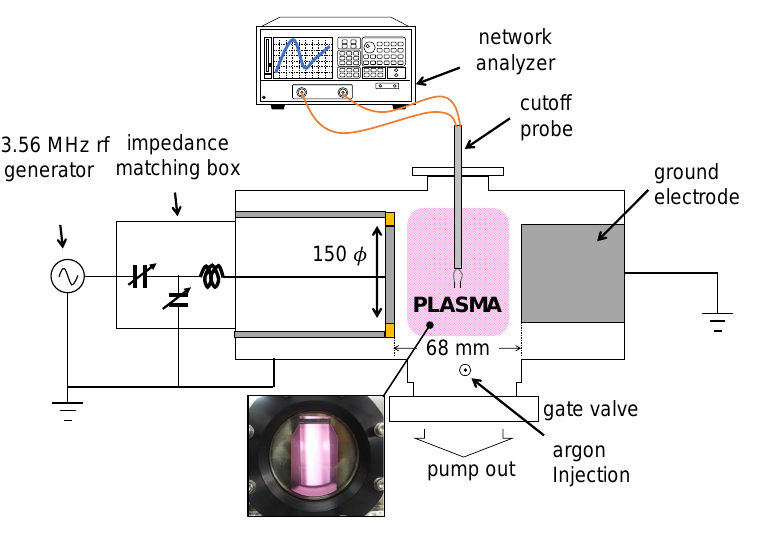
Figure 3. Schematic diagram of the experimental setup in a capacitively coupled plasma source.